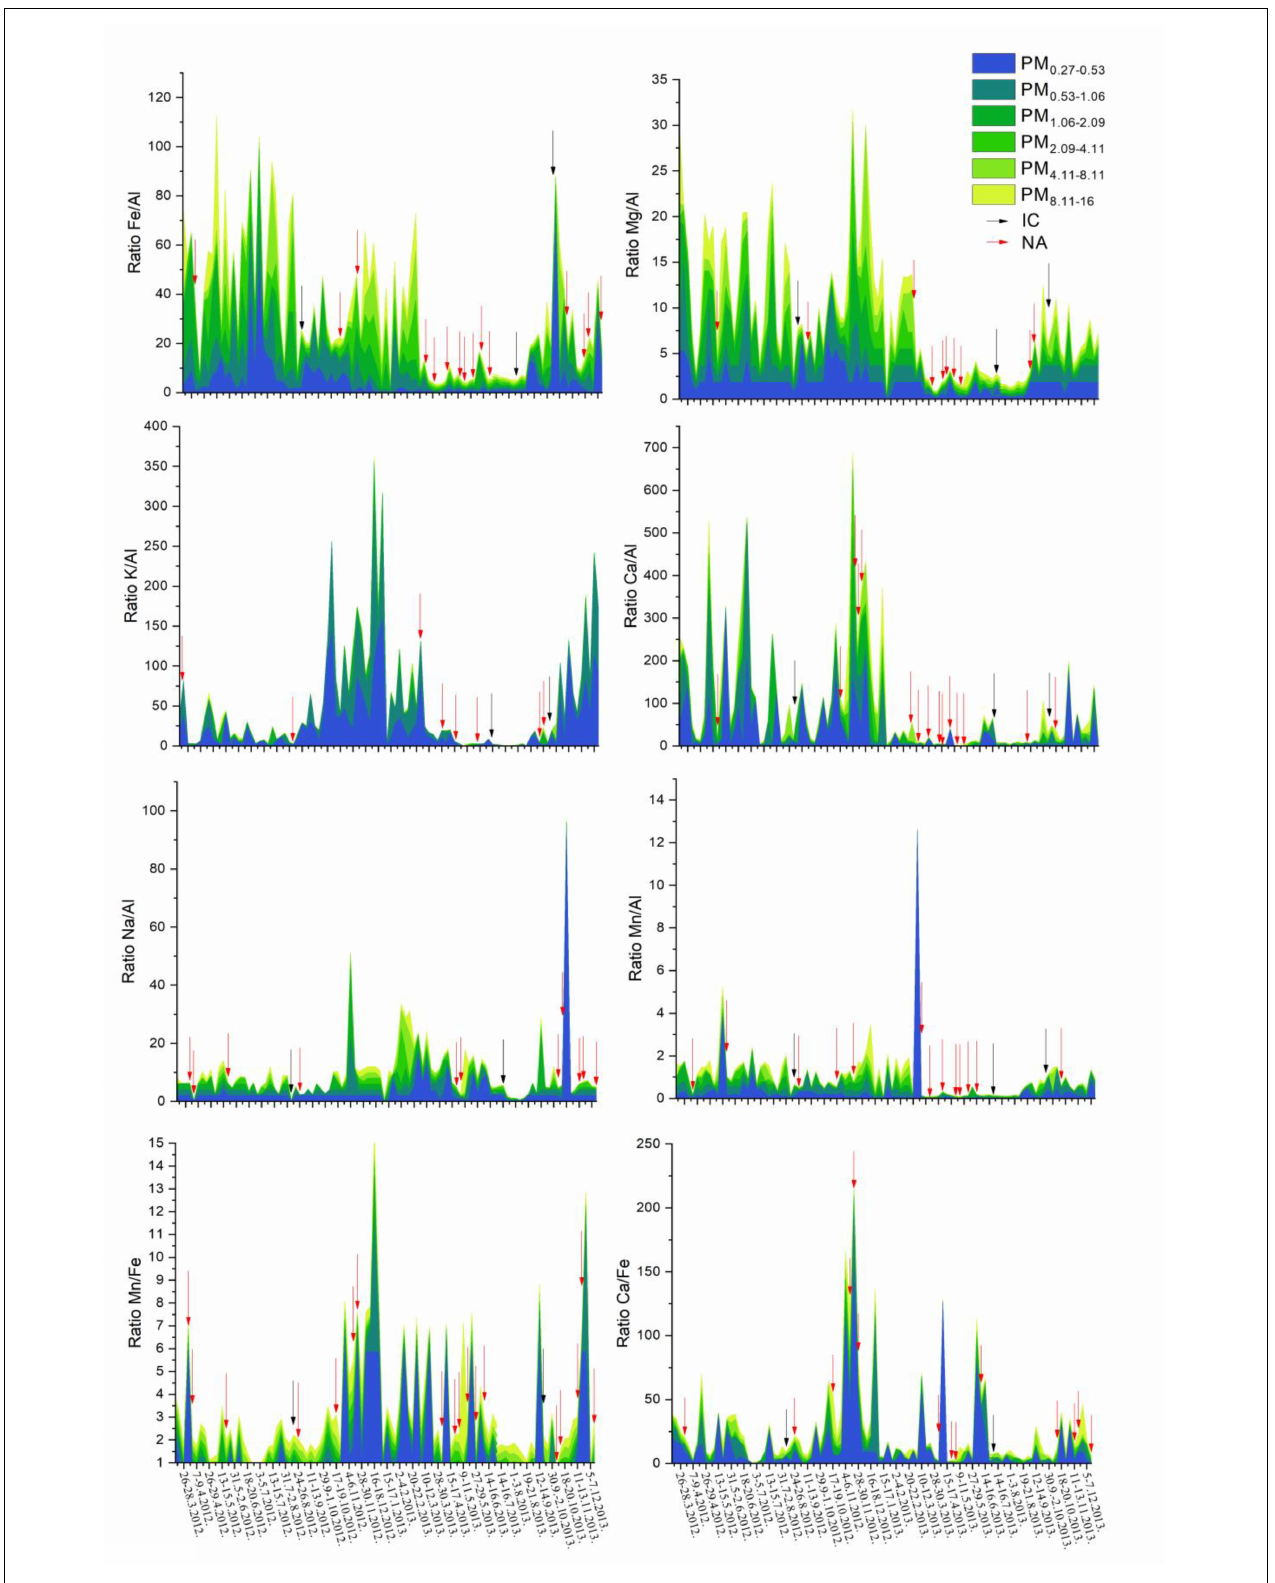
FIGURE 5 | Temporal variations of elements ratios with episodes of Icelandic dust (IC) and North Africa dust (NA).